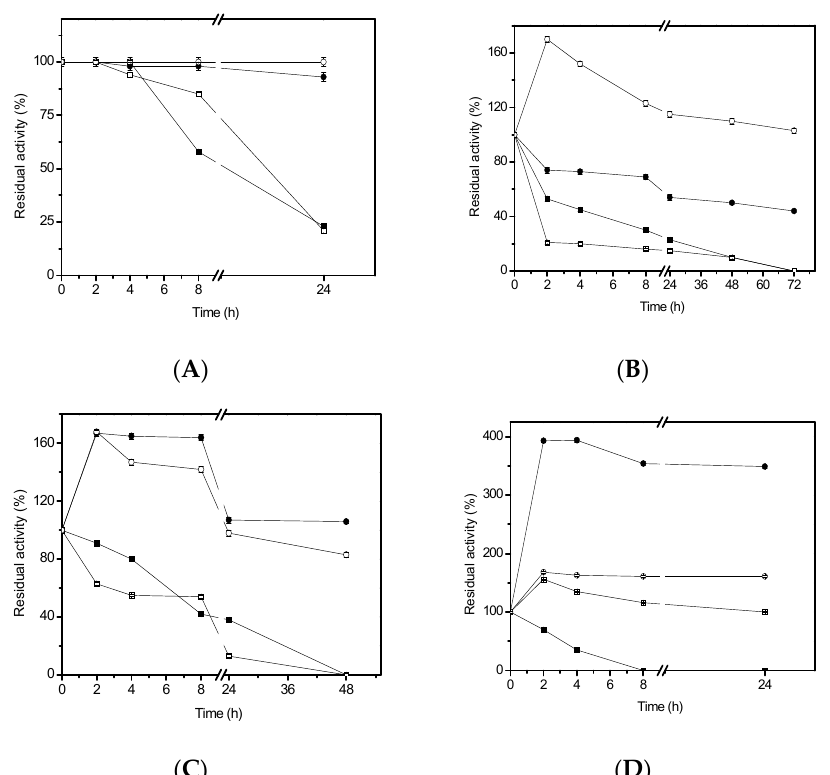
Figure 3. Stability of derivatives in organic solvents. ( A ) ethanol; ( B ) methanol; ( C ) n -propanol; ( D ) cyclohexane. Symbol: ■ CNBr derivative; ● GA-crosslink derivative; □ GX derivative; ○ GA derivative.